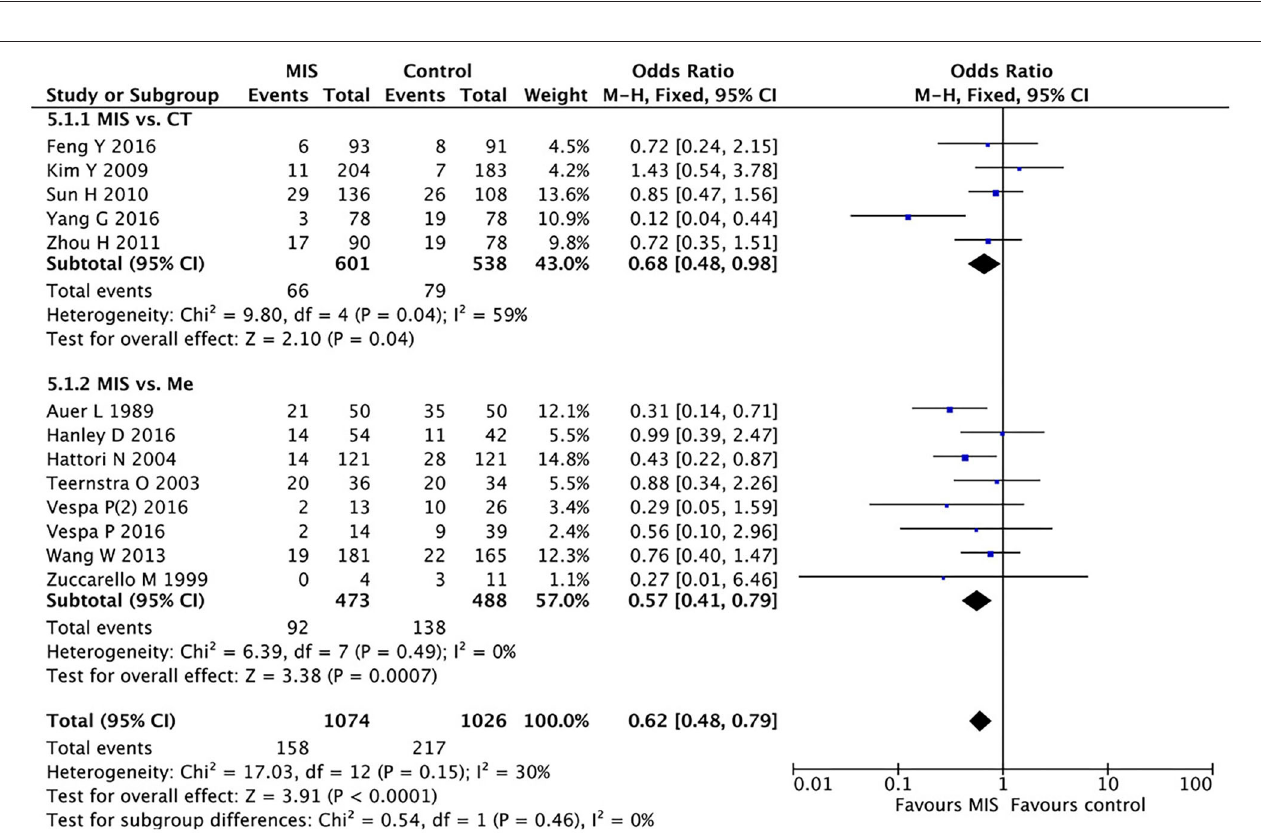
FIGURE 4 | A forest plot of the hematoma evacuation rate.